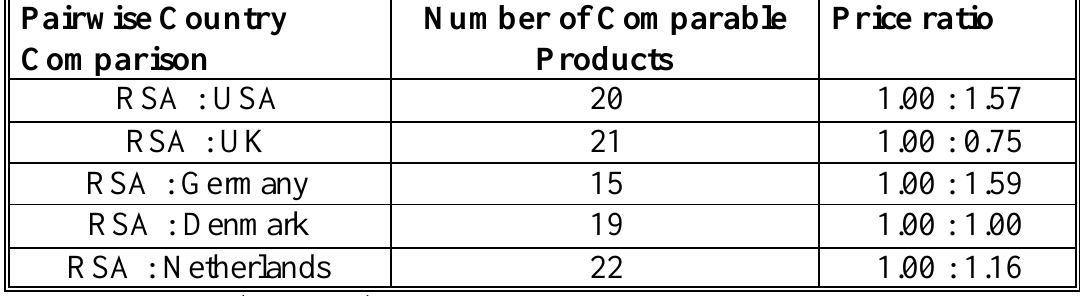
Table 3 Six country comparison - top 50 products (1995) Pairwise Country